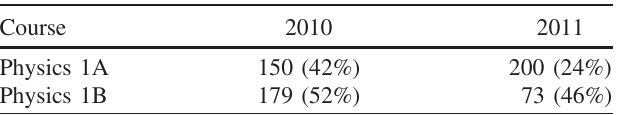
TABLE III. Criteria used to define high quality questions. TABLE IV. Number of questions sampled across all courses (percentages in brackets give the fraction of the course repository that was sampled in each